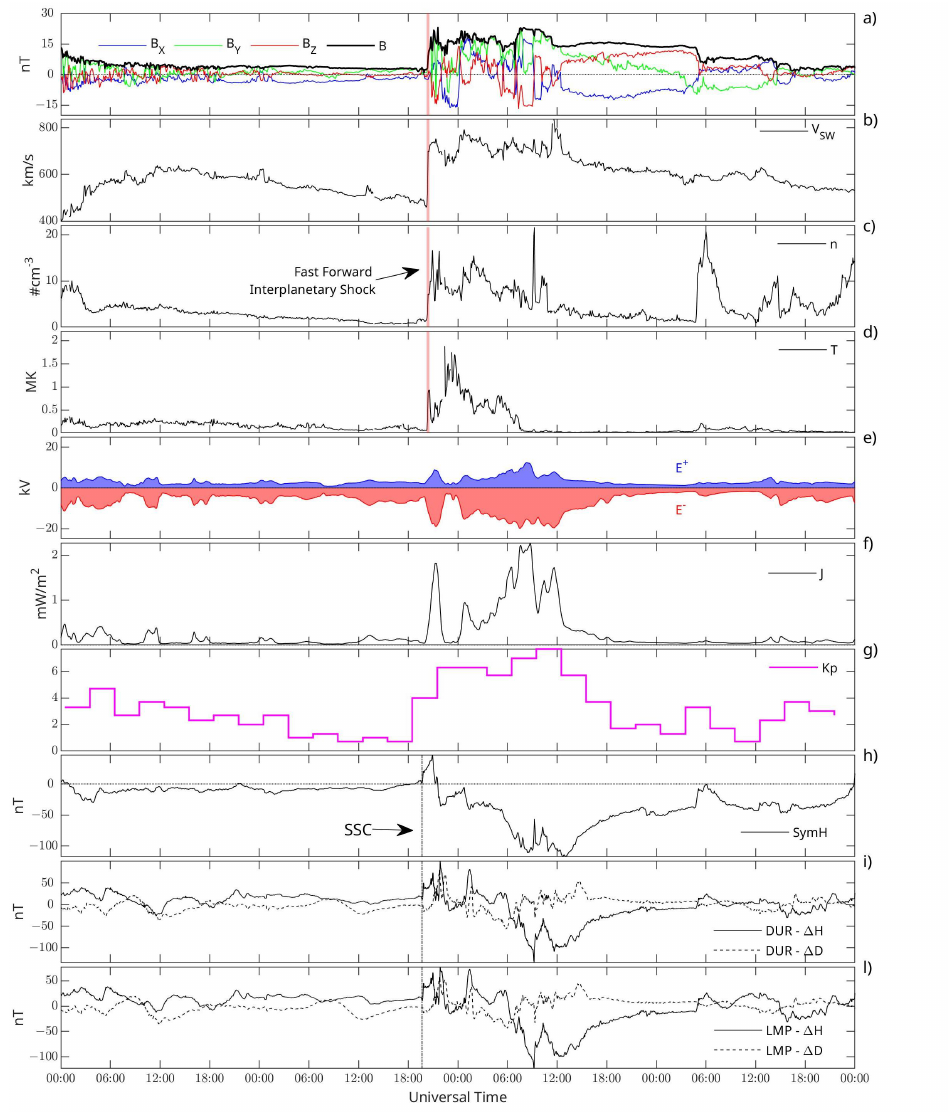
Figure 2. The SW, IMF parameters and geomagnetic activity during 2–5 November 2021. ( a ) In- terplanetary magnetic field components and strength; ( b ) radial solar wind speed; ( c ) solar wind plasma density and ( d ) temperature; ( e ) positive and negative average horizontal electric potentials in the northern hemisphere and ( f ) average Joule heating J; geomagnetic activity indices ( g ) Kp and ( h ) SymH; geomagnetic field fluctuations at 1 min time resolution at Italian observatories of ( i ) DUR and ( l ) LMP. The vertical red strip ( a – d ) refers to the FF IP shock. The vertical black dotted line ( h , i , l ) refers to the